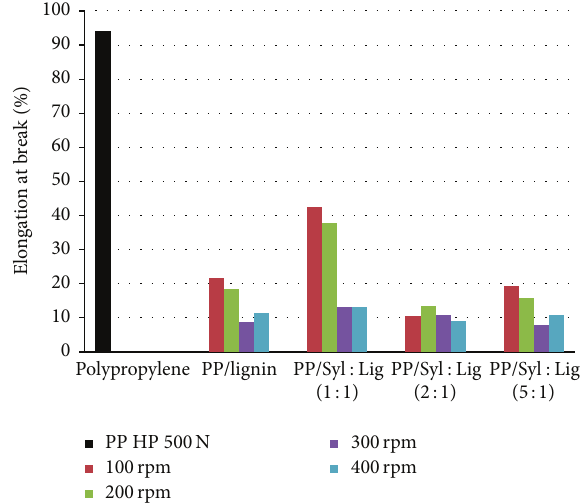
Figure 11: Elongation at break obtained during static uniaxial deformation versus applied screw